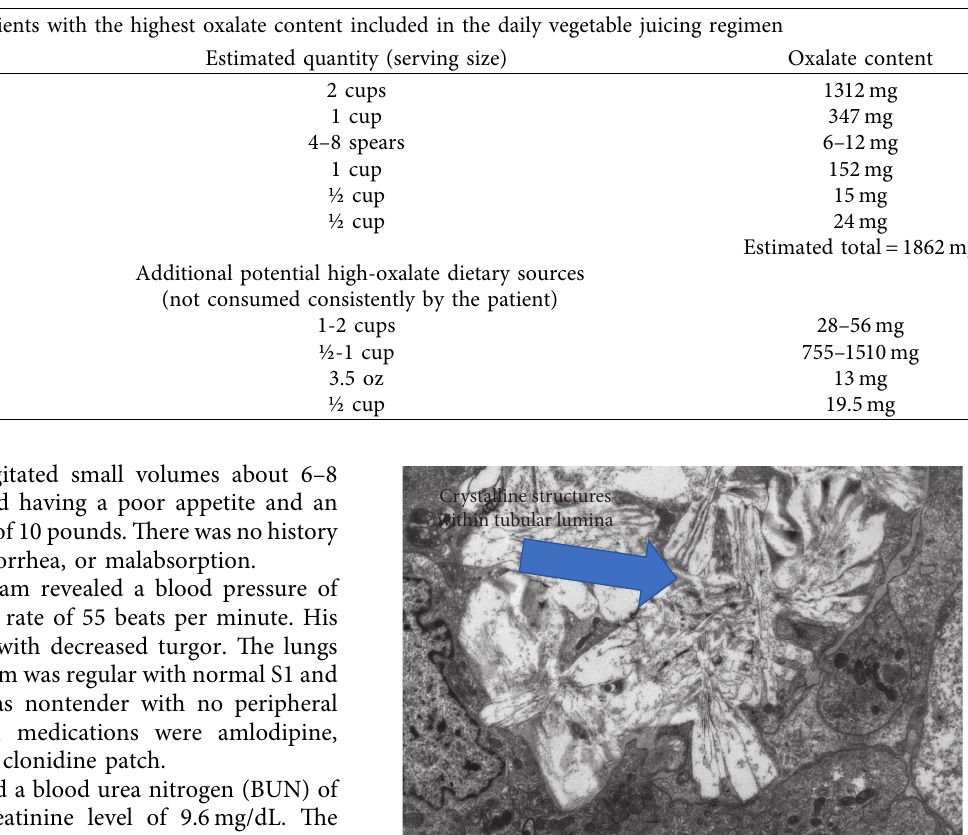
Figure 1: EM showing multiple oxalate crystals in the lumen of the kidney tubule.